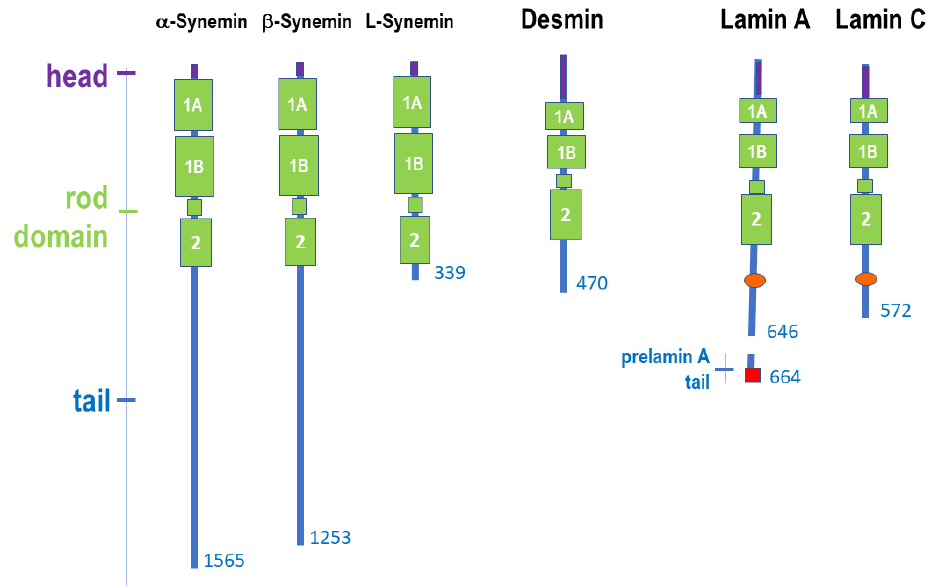
Figure 2. Schematic representation of α -Synemin, β -Synemin, L-Synemin, Desmin, Lamin A and Lamin C protein structure. Each intermediate filament protein has: a head domain (purple); a rod domain including coil1A (1A), coil 1B (1B), a linker domain called L12 (small green box) and coil 2 (2); a tail domain (blue), which can be of variable length even in protein isoforms. Lamin A and C have a globular domain (orange) in their tail. Prelamin A-specific tail with C-terminal CAAX box (red) is also represented. Prelamin A tail is removed upon protein post-translational processing to yield mature Lamin A. α -Synemin, β -,Synemin and L-Synemin are splicing products of SYNM gene, Desmin is the product of DES gene, Lamin A and C are splicing products of LMNA gene. The number of amino acids is indicated at the C-terminus for each protein.